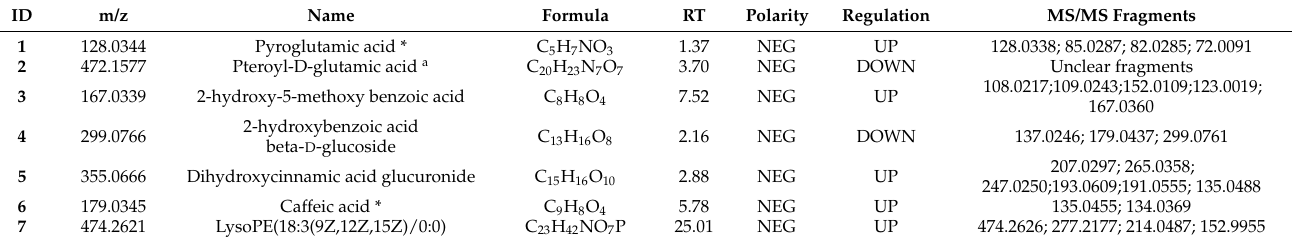
Table 1. Metabolites identified and confirmed by MS/MS in strawberry and apple